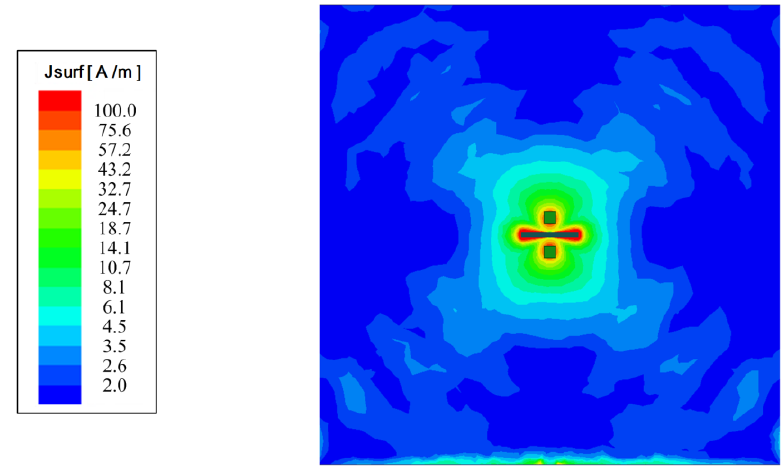
Figure 6. Currents distribution on the top layer of the SIW at 24 GHz.